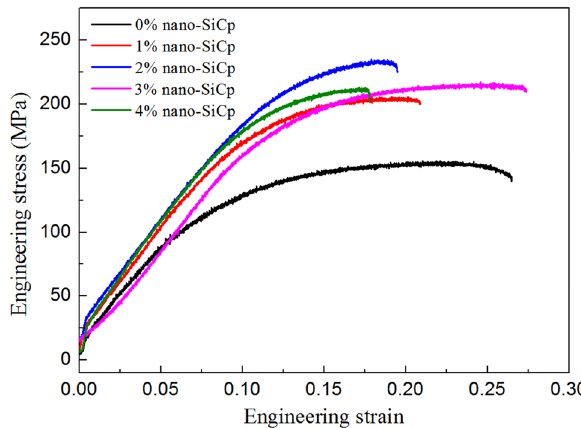
Figure 5: The engineering stress - strain curves of nanocomposites with di ff erent SiCp volume fractions.